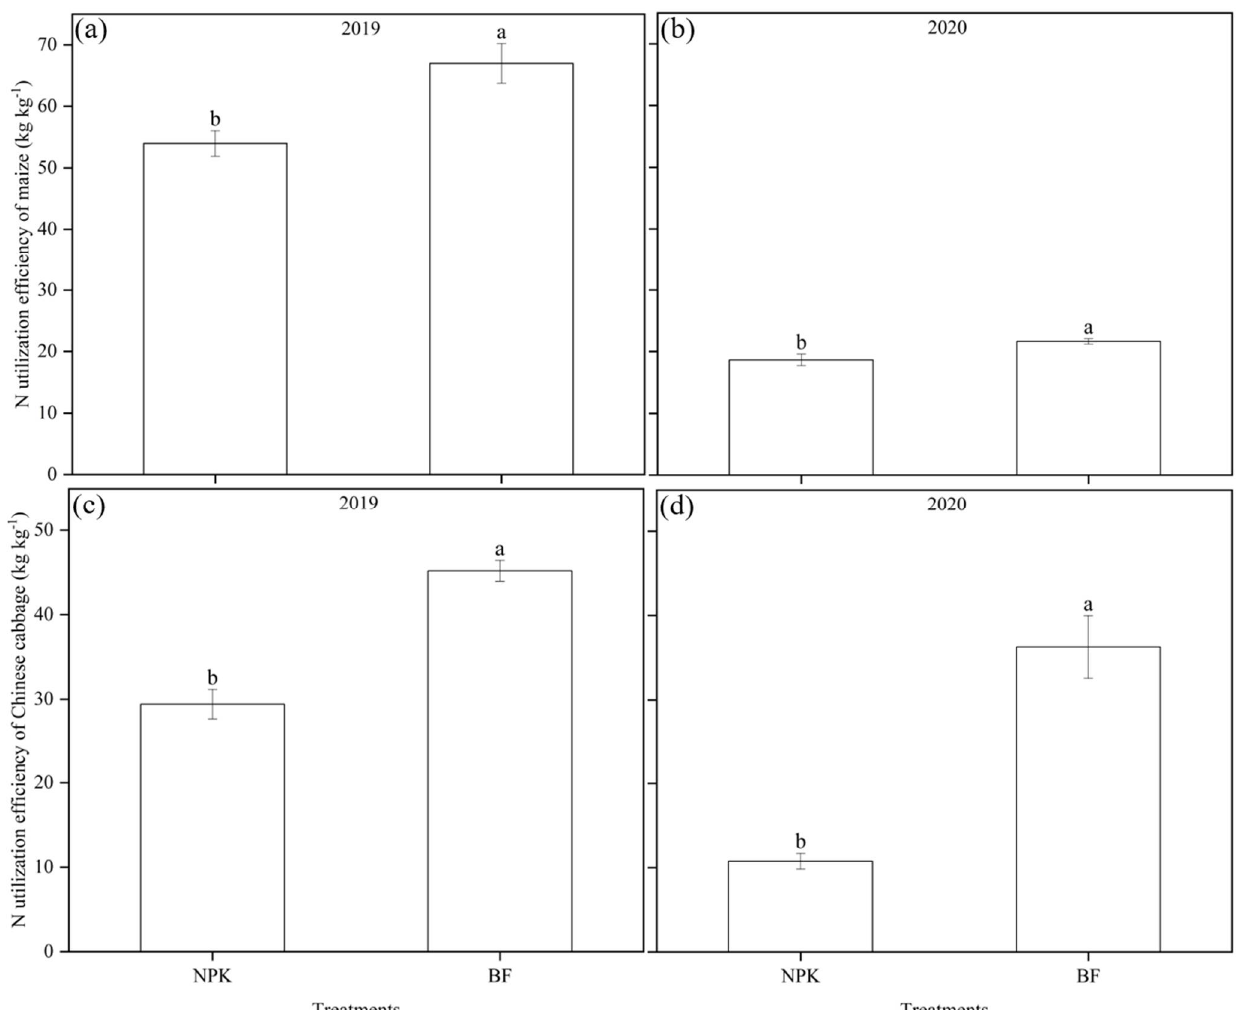
Figure 5. N utilization efficiency of maize and Chinese cabbage in 2019–2020 under different N treatments. ( a ), N utilization efficiency of maize in 2019. ( b ), N utilization efficiency of maize in 2020. ( c ), N utilization efficiency of Chinese cabbage in 2019. ( d ), N utilization efficiency of Chinese cabbage in 2020. The error bars show the standard deviations of the means (n = 3). Different lowercase letters indicate significant differences among treatments ( p < 0.05).